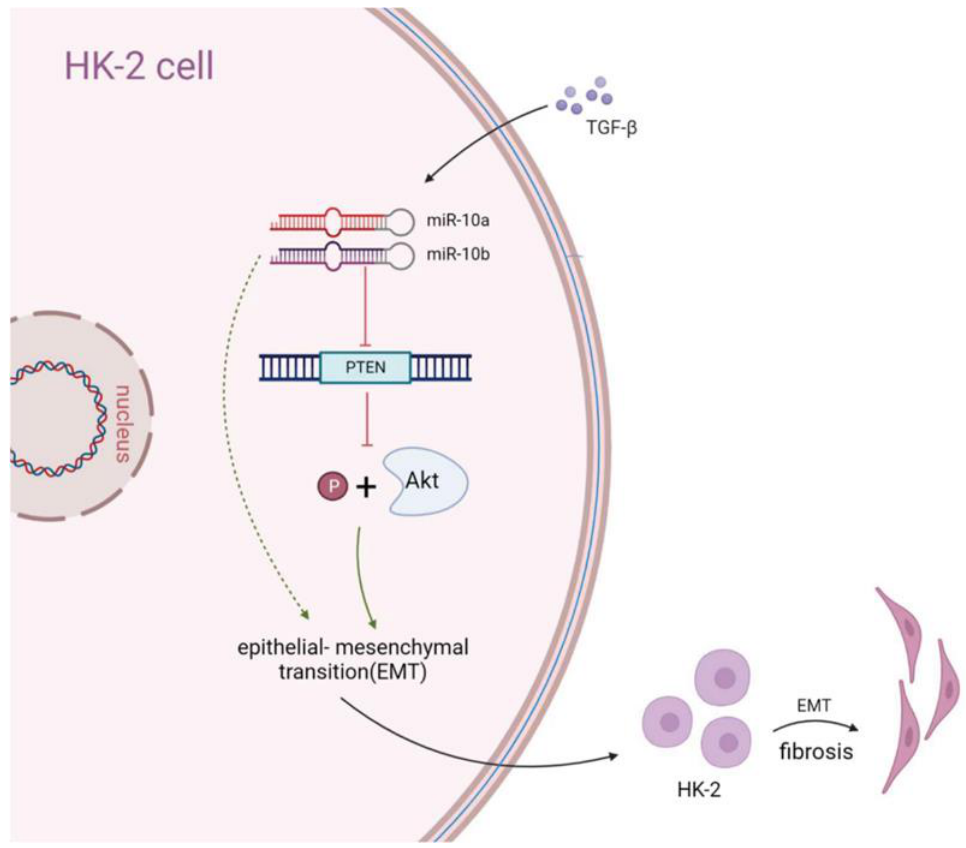
Figure 6. Schematic for miR-10a and miR-10b promoting the EMT of RF through the PTEN/Akt pathway. The black arrow represents the regulatory process, the red arrow represents the inhibitory effect, the green arrow represents the promoting effect and the dotted green arrow represents the indirect effect.